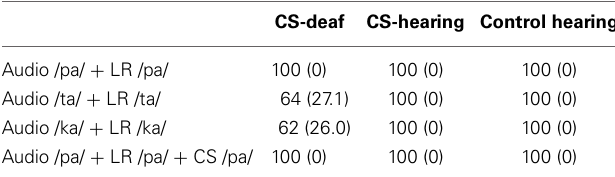
Standard deviations are indicated in